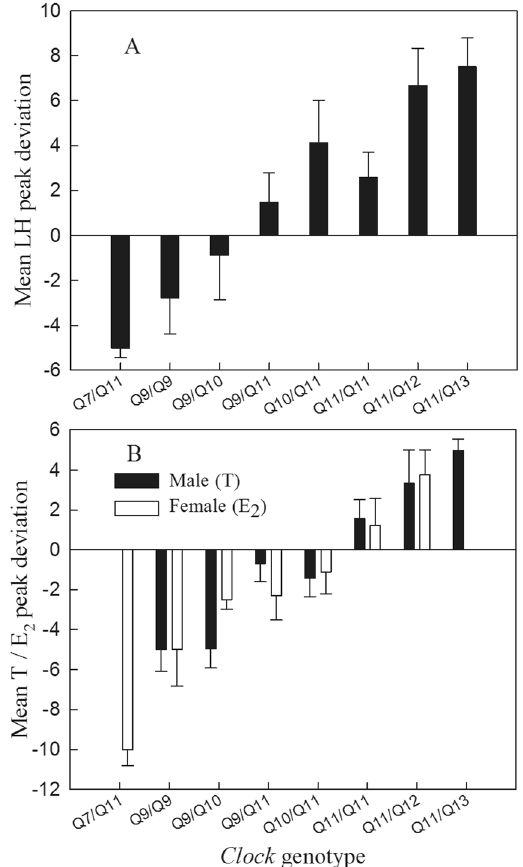
Figure 3. The LH, T and E 2 mean peak date deviation of all Clock poly-Q genotypes. The mean LH, T and E 2 peak date of the population in each year was scored as 0. The peak deviation of an individual bird was defined as the deviation days from the population peak